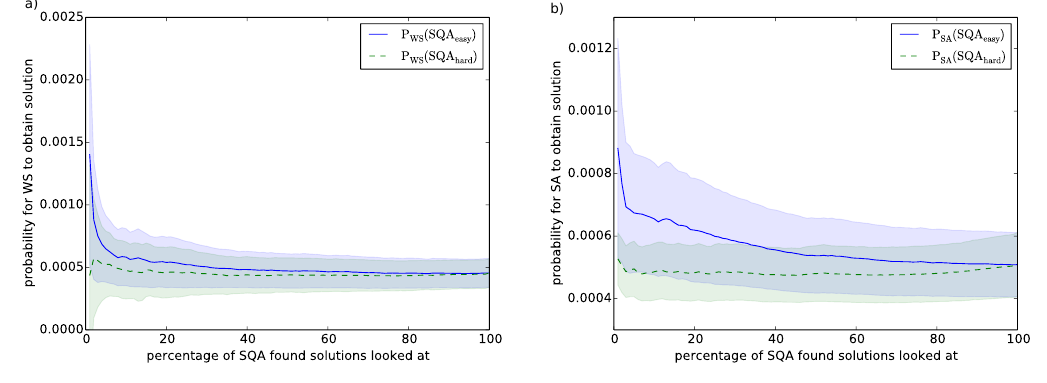
Figure 5: Probability for a) WS and b) SA to find the SQA-hardest and SQA-easiest solutions. The x-axis indicates the percentage of easiest and hardest SQA-found solutions, running SQA 2000 times on 20 randomly generated 4-SAT instances with n = 50 variables and a clauses- ≈ 8.06. An average was taken over the to-variables-ratio of α χ 4